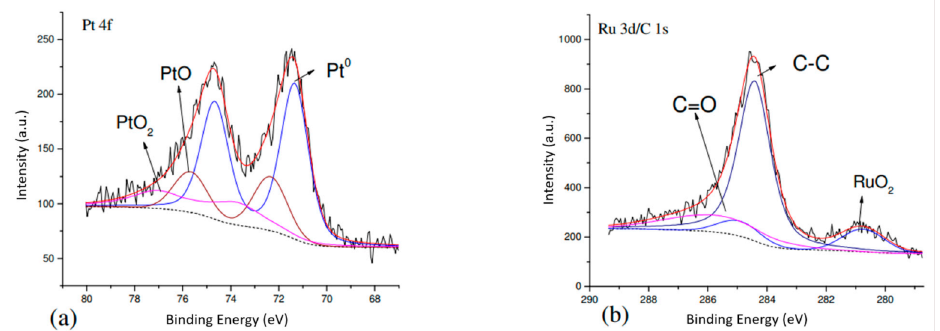
Figure 5. XPS spectra of PtRu/carbon-01. ( a ) Pt 4f spectra; ( b ) Ru 3d/ C 1s